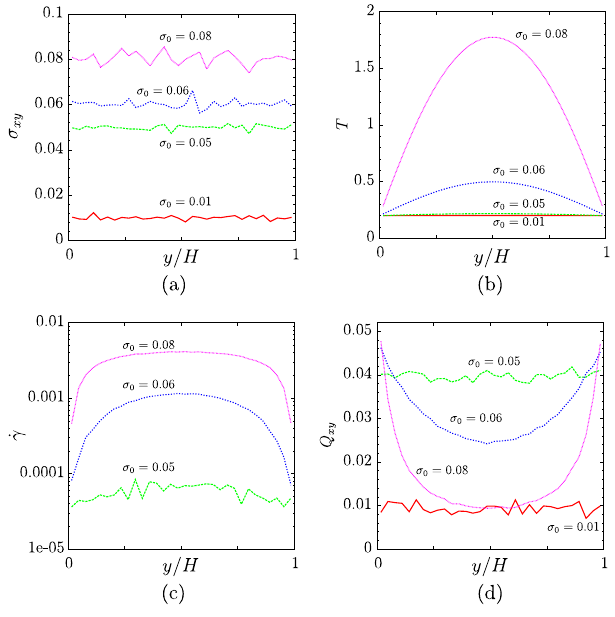
FIG. 3. The spatial variation in the (a) shear stress σ xy ð y Þ , (b) temperature T ð y Þ , (c) shear rate _ γ ð y Þ , and (d) xy component of the bond-orientation tensor in Eq. (8) for various values of σ 0